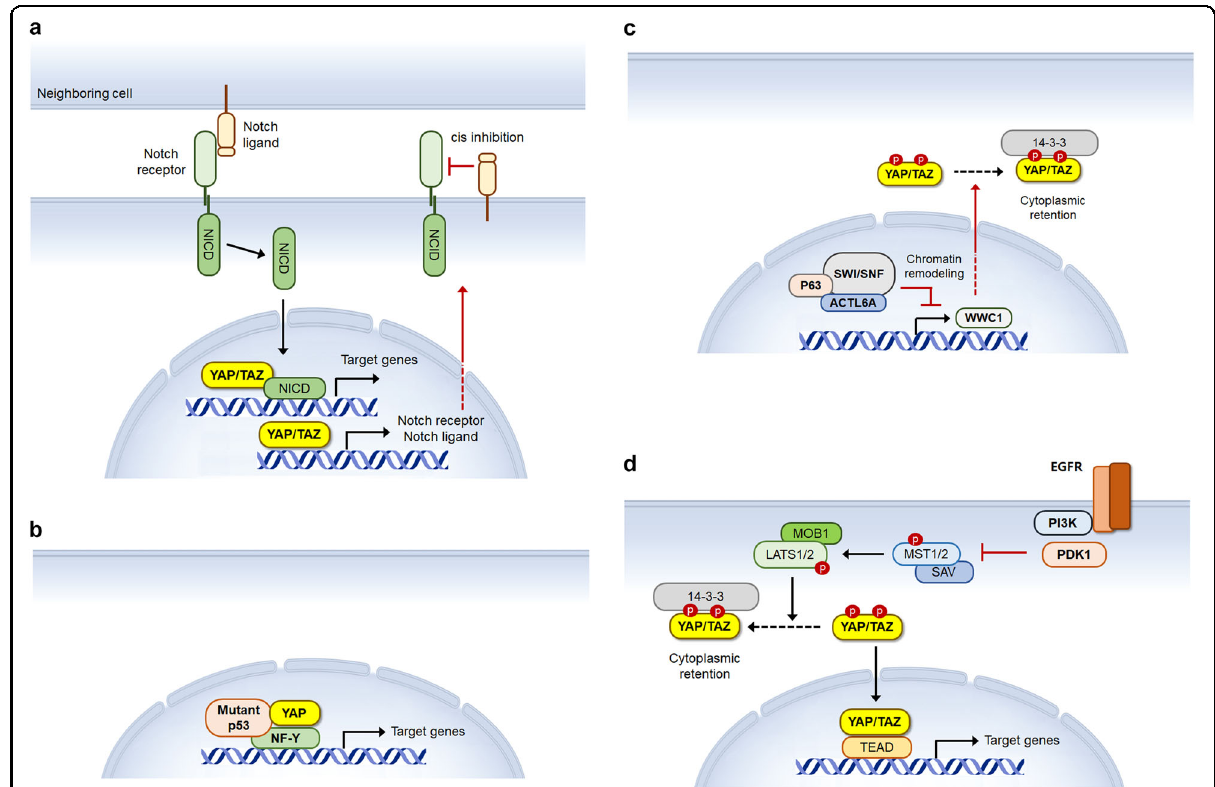
Fig. 5 Schematic representation of interactions between YAP and other oncogenic drivers. a Activated YAP and TAZ regulate the expression not only of the common target genes along with NICD but also of Notch receptors and ligands. b The YAP/mutant-p53/NF-Y complex increases the expression of cell-cycle-related genes. c p63/ACTL6A-dependent chromatin remodeling promotes YAP/TAZ activation by suppressing WWC1 expression. d Activated PI3K induces the dissociation of PDK1 from the core Hippo kinase complex, leading to the inactivation of Hippo